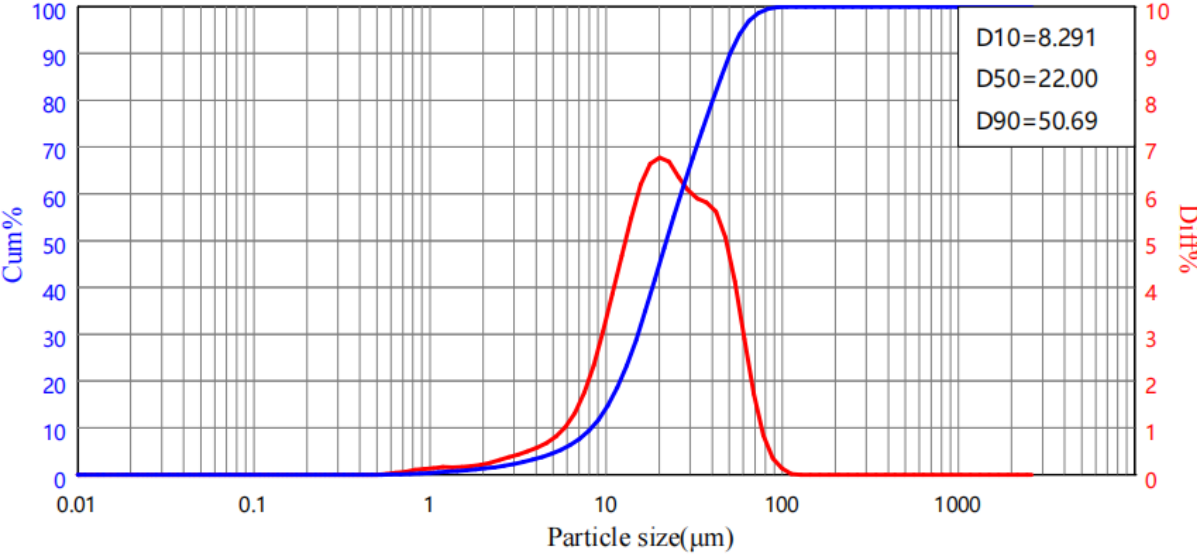
Figure 5. Diagram of distribution of DS-1 particle sizes.